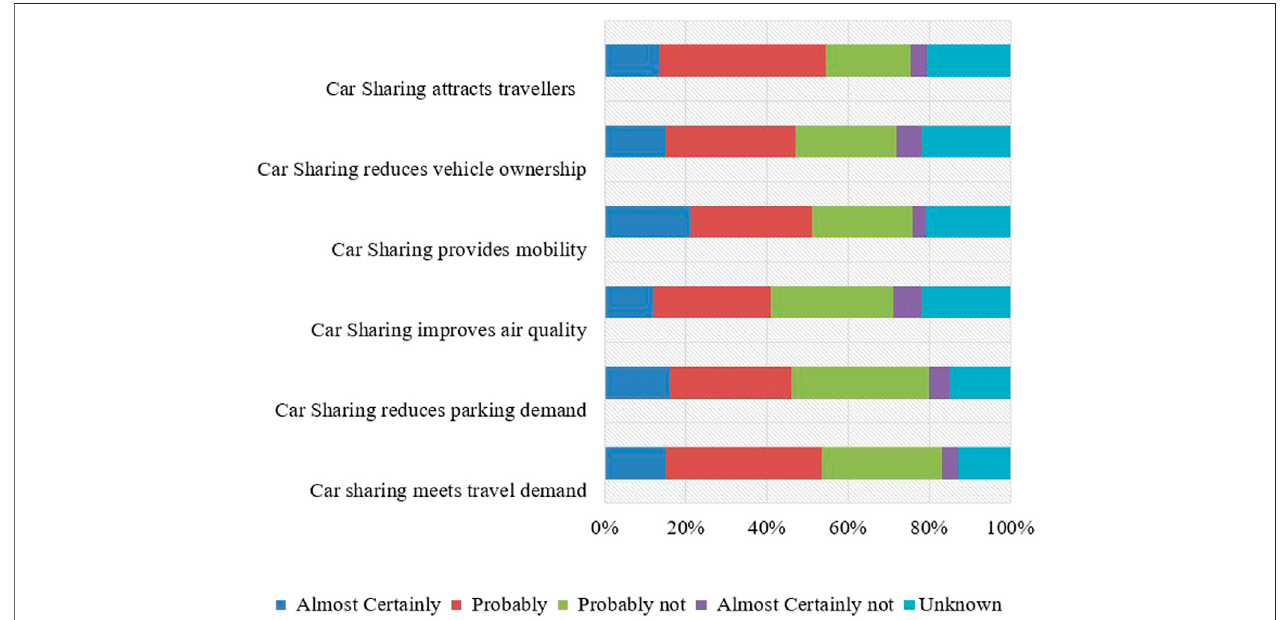
FIGURE 8 | Car sharing awareness and perception.